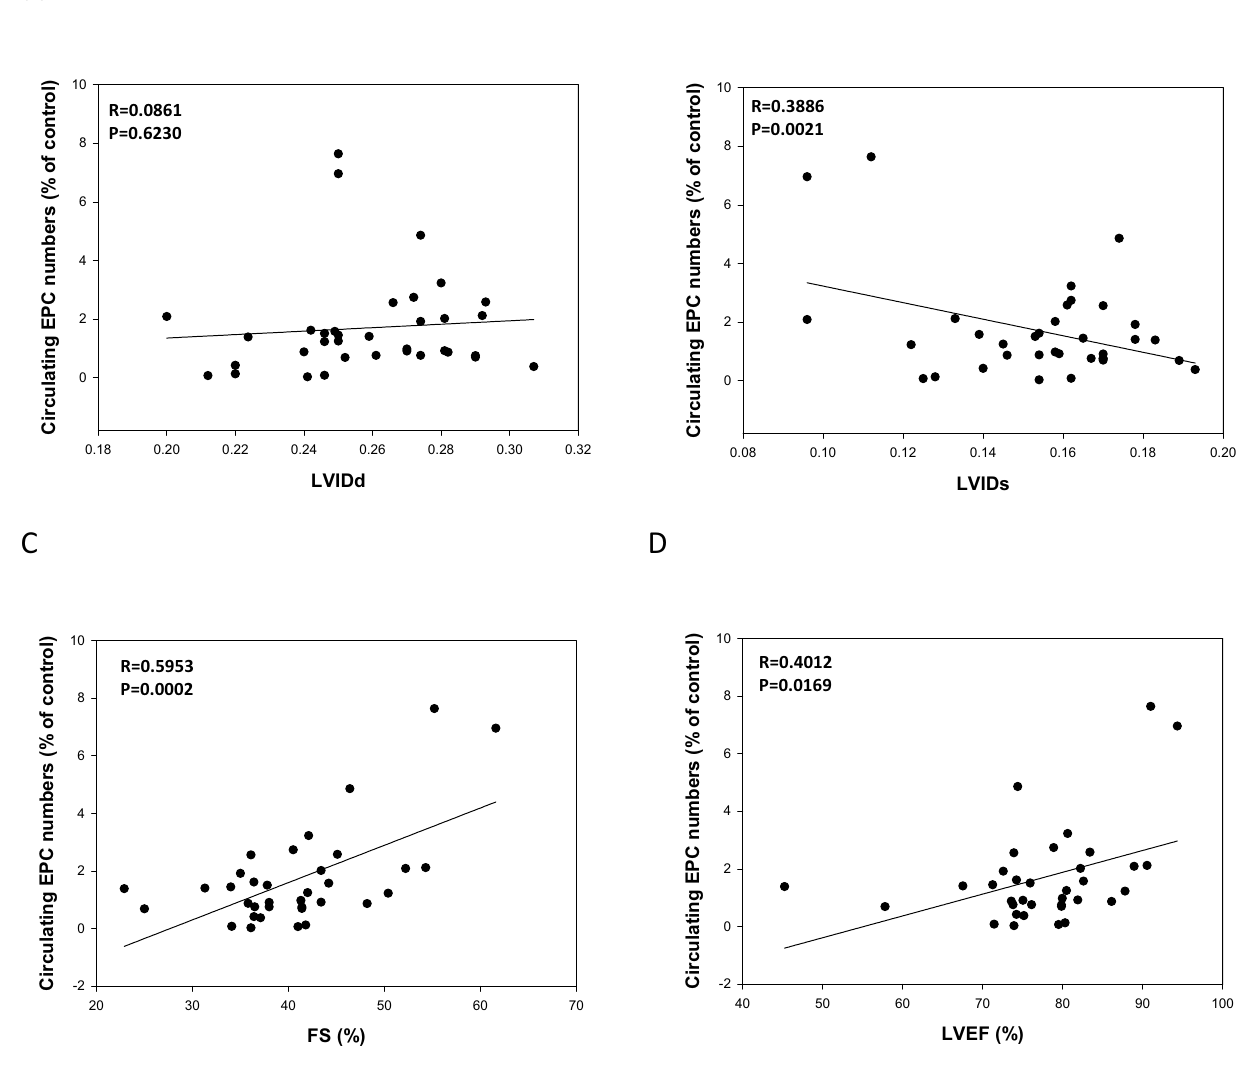
Figure 2. Correlations among circulating EPC cell numbers (%) and LVIDd levels ( A ); circulating EPC cell numbers (%) and LVIDs levels ( B ); and circulating EPC cell numbers (%) and LVFS levels ( C ), and LVEF levels ( D ) in FBV mice after DOX IV injection at 5 weeks (n =